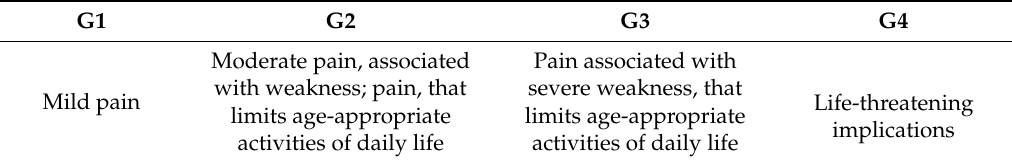
Table 1. Classification of the severity of ICI-related myositis